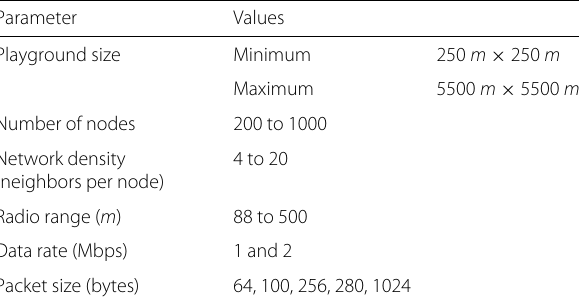
Table 11 Network densities of simulated topologies